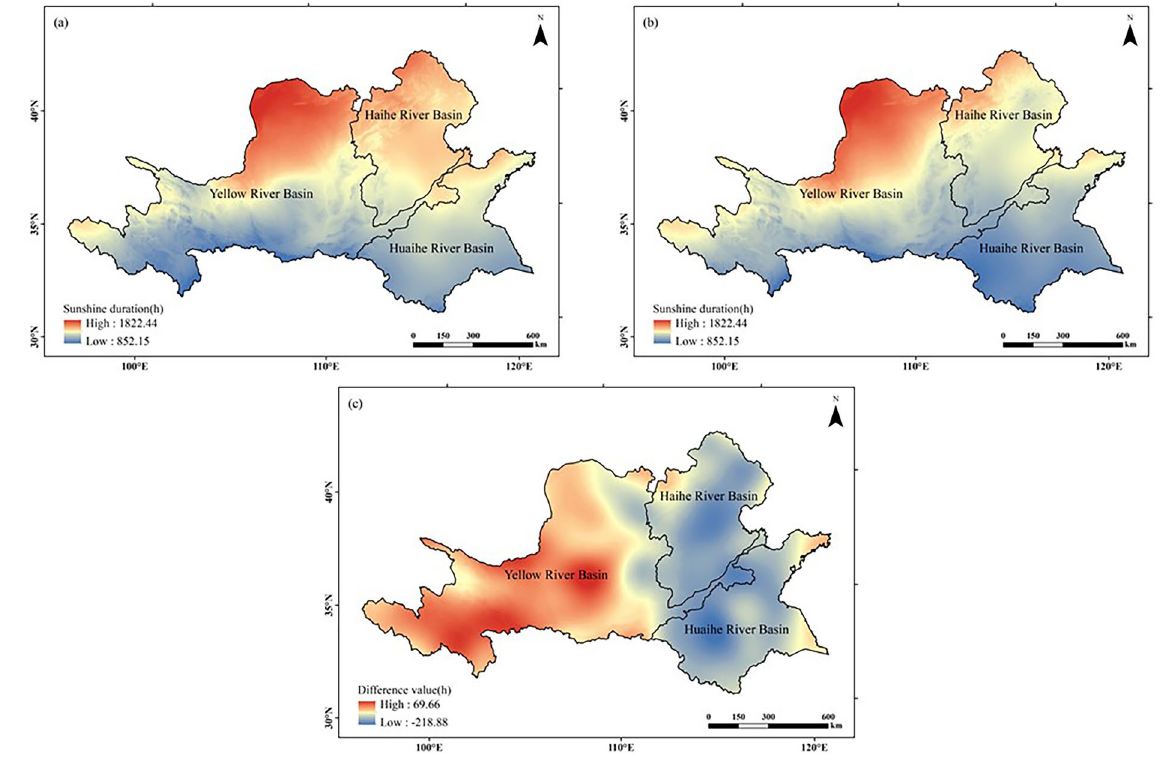
Figure 4. Comparison of the distribution of seasonal sunshine duration for peanut growth in the Huang-Huai- Hai region during two climatic years: ( a ) 1960–1989, ( b ) 1990–2019, ( c ) ( b )–( a ). The figure was made in the ArcGIS 10.2 platform (https:// www. esri. com/ en- us/ home).